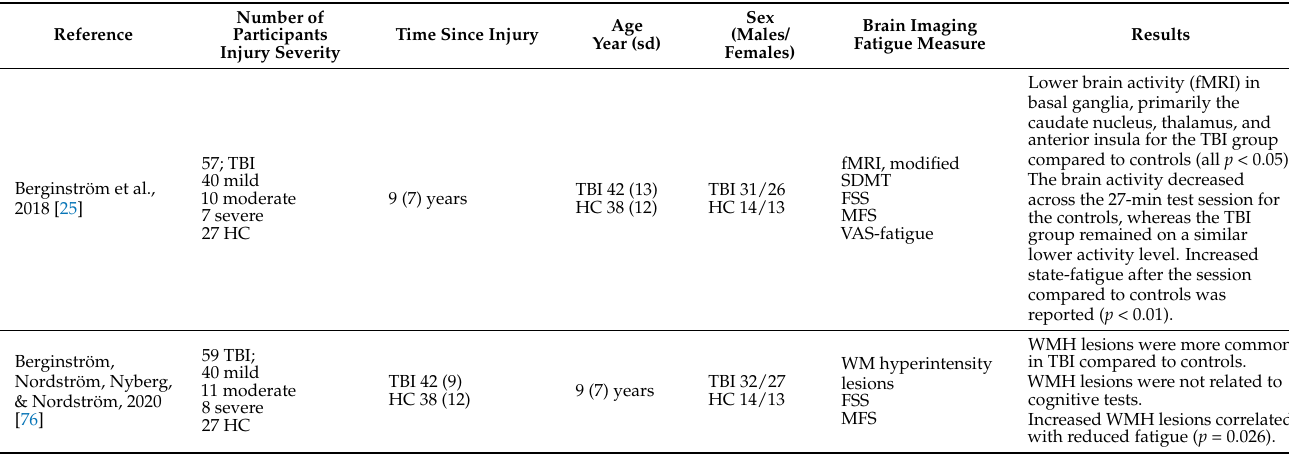
Table 2. Research relating fatigue in adults after TBI to brain imaging techniques. Summary of study characteristics, including details on study sample, methods, and